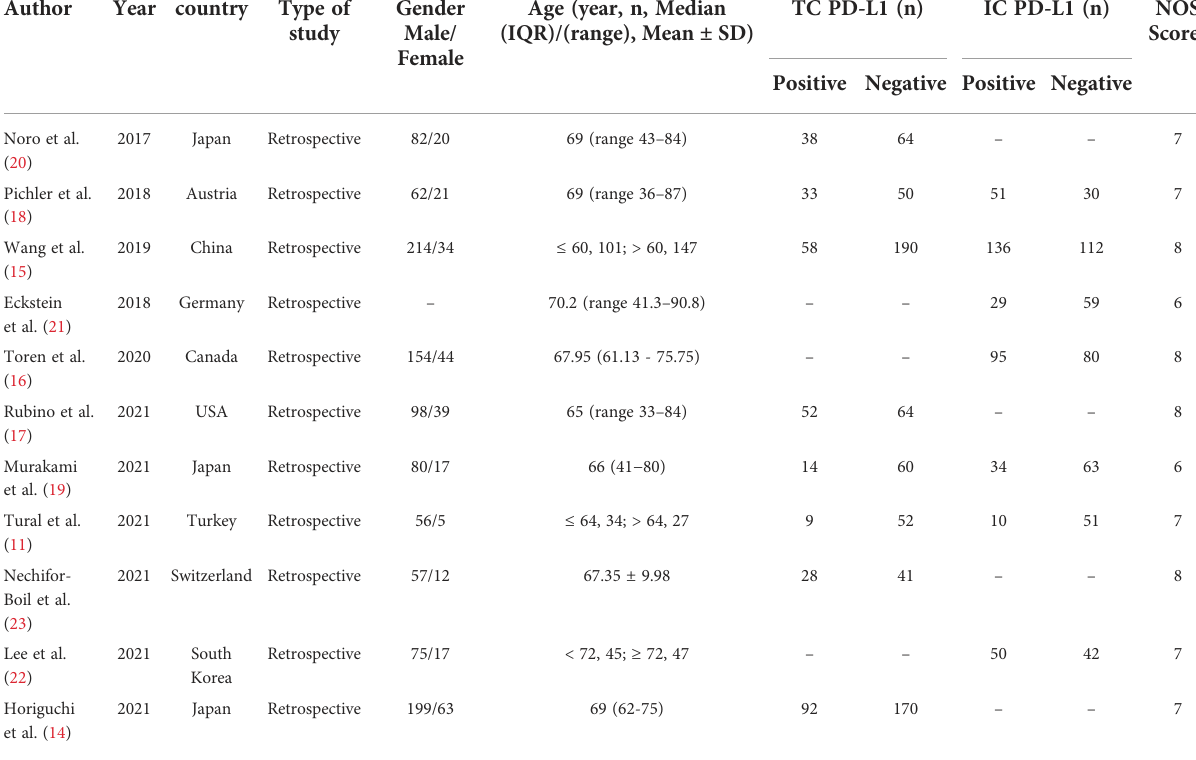
TABLE 1 Characteristics and quality of included